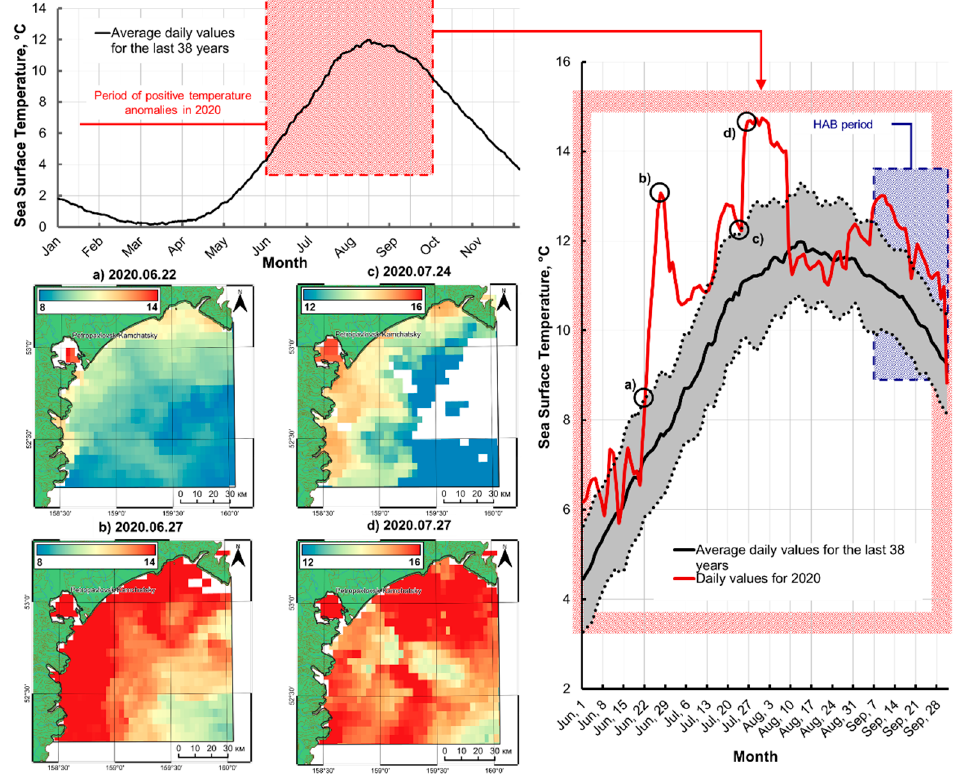
Figure 6. Graphs characterizing the annual variation of daily SST (sea surface temperature) values for 2020 (red line) and summarized for the period from 1981 to 2019 SST values (black line denotes average values, dashed lines denote standard deviations) based on NOAA OISST data processing. The insets ( a – d ) based on MODIS data show spatial distributions of SST on 22, 27 June and 24, 27 July (when the most intensive anomalies had been formed).